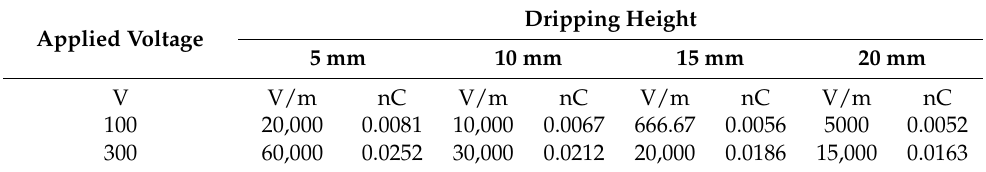
Table 2. The net charge amount to an electrified DI water droplet.